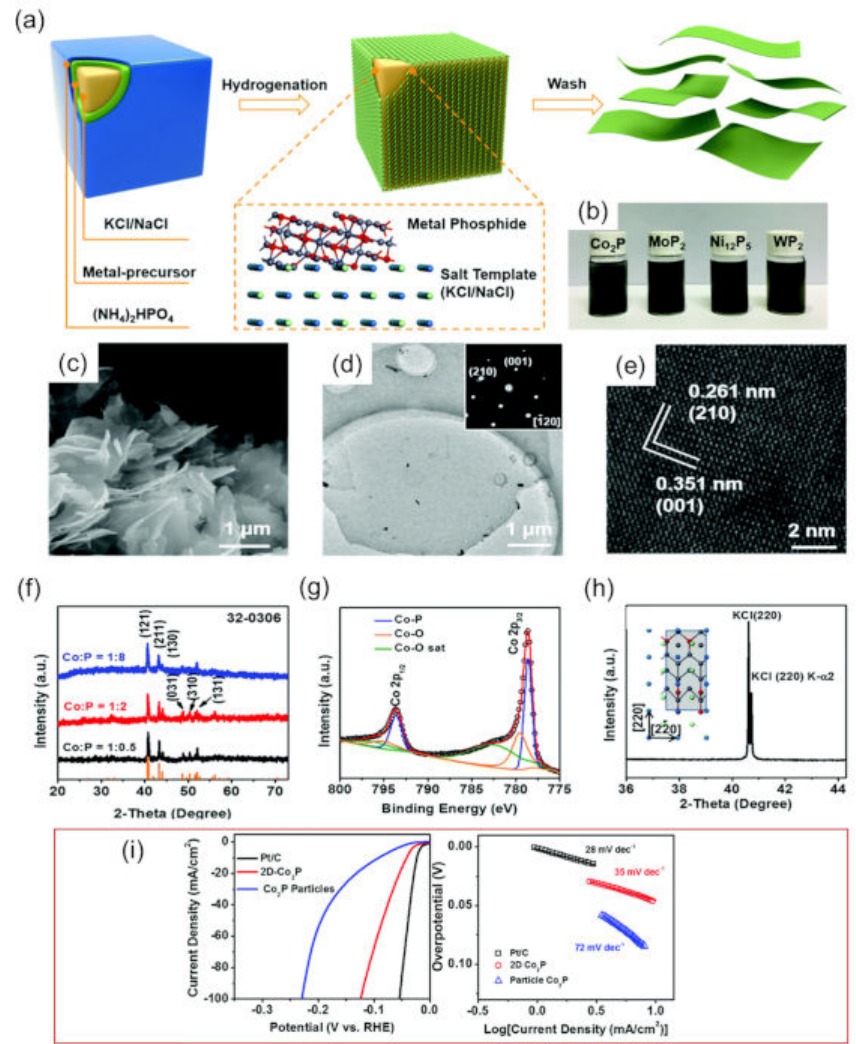
Figure 6. The characterization and synthesis mechanism of 2D Co 2 P. ( a ) Schematic diagram of the preparation of 2D metal phosphides. ( b ) The optical images of the as-synthesized 2D metal phosphide dispersions. ( c ) SEM, ( d ) TEM, and ( e ) HR-TEM images of 2D Co 2 P (inset: the corresponding SAED pattern). ( f ) XRD patterns of Co 2 P with different atomic ratios in the precursor. ( g ) XPS spectra of Co 2 P. ( h ) XRD pattern of 2D Co 2 P on KCl. ( i ) Polarization curves and Tafel plots of 2D Co 2 P, Co 2 P particles, and commercial Pt/C. Reprinted (adapted) from Reference [45], copyright (2018) Royal Society of